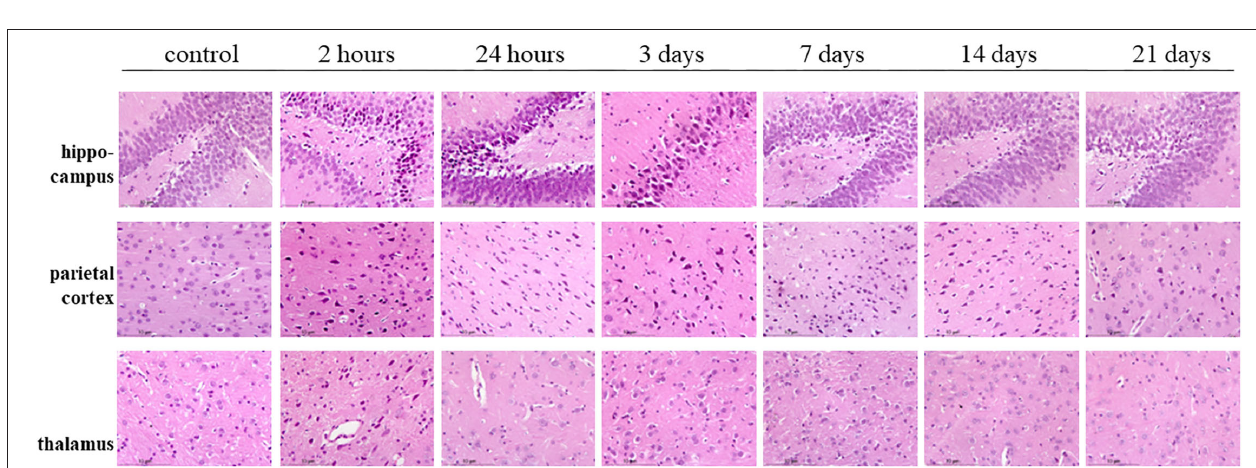
FIGURE 8 | Hematoxylin–eosin staining of the hippocampus, parietal cortex, and thalamus in rat brains at multiple time points after